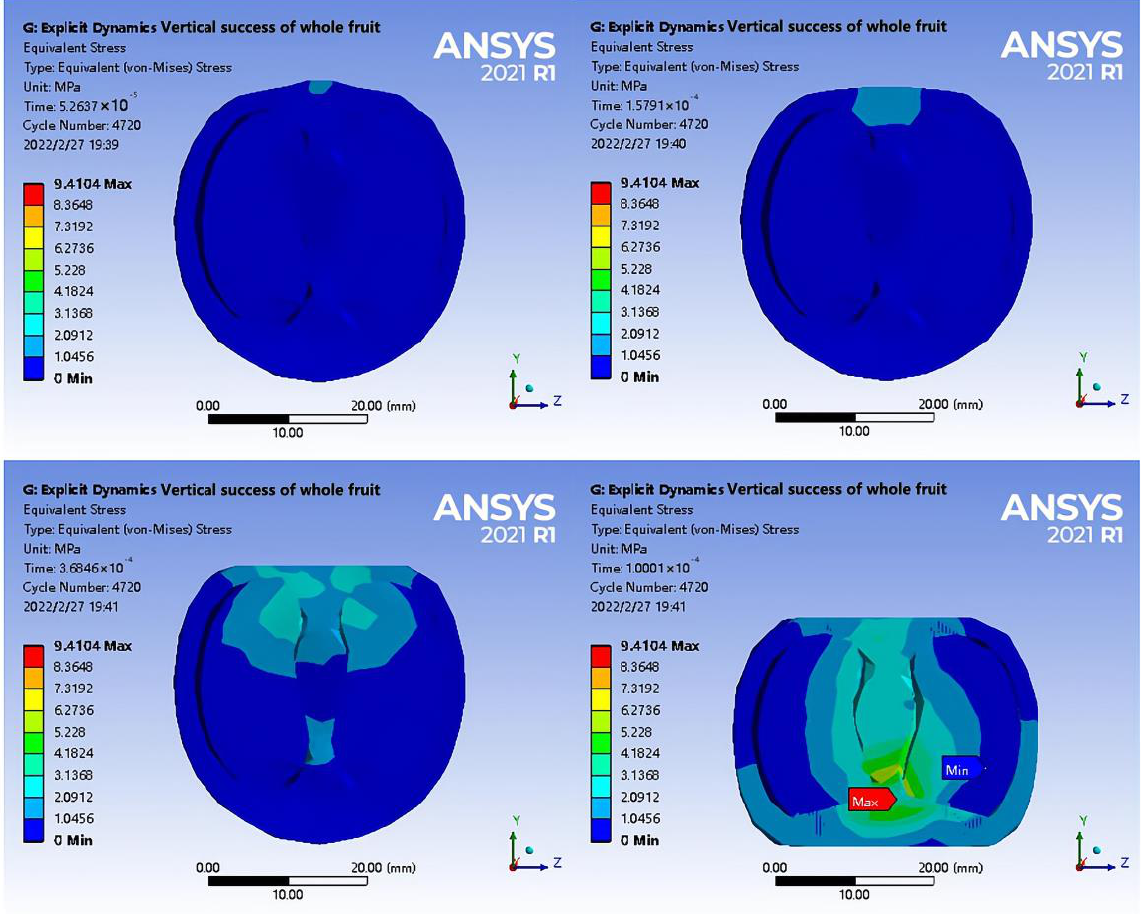
Figure 11. Axial loading stress change diagram of half-section fruit.